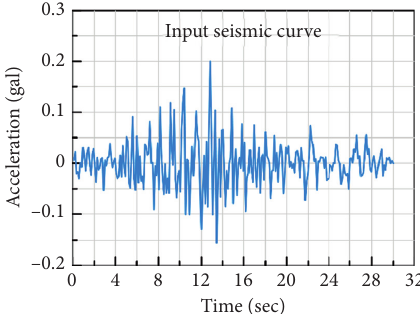
Figure 4: Time course curves for bedrock seismic